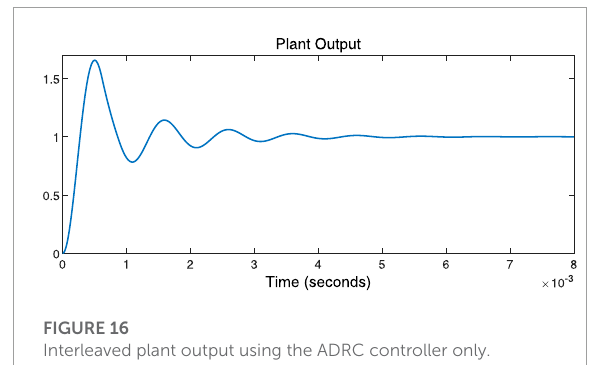
FIGURE 16 Interleaved plant output using the ADRC controller